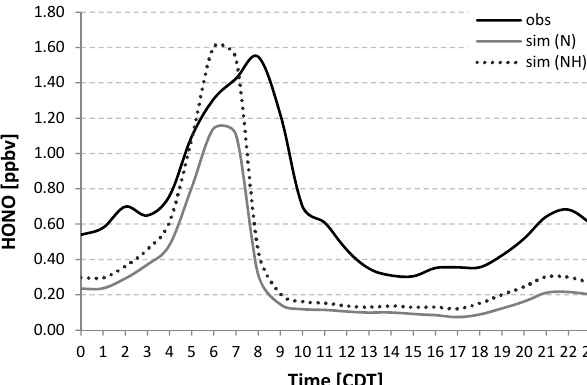
Figure 7. Average diurnal variation of HONO at the Moody Tower measurement